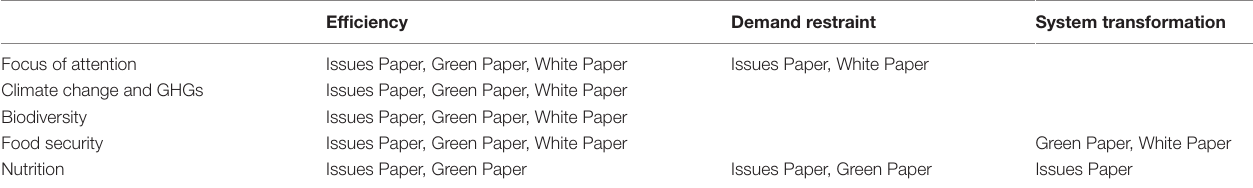
TaBle 4 | Frame analysis of food system sustainability perspectives in the